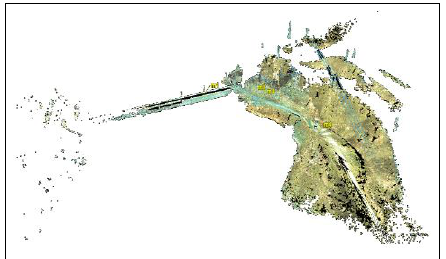
Figure 5 . TLS point cloud